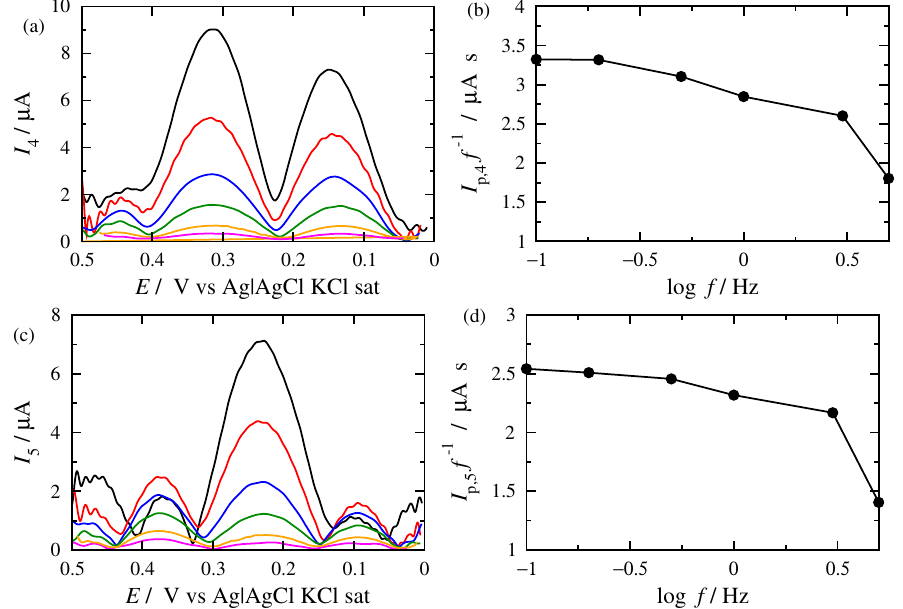
Figure 5. Experimental results: ( a ) 4th harmonics, ( b ) normalised peak height of the 4th harmonic, ( c ) 5th harmonics and ( d ) normalised peak height of the 5th harmonic, of Mt LPMO9H immobilised on a Co-f-MWCNTs modified GC electrode at 25 ◦ C. Experimental conditions: acetate buffer 500 mM, pH 6, A 0 = 0.25 V, and f = 5 (black), 3 (red), 1 (blue), 0.5 (green), 0.2 (orange) and 0.1 (magenta)